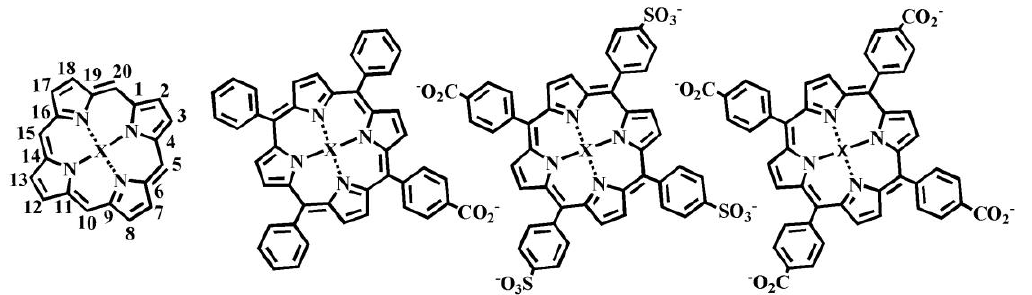
Figure 1. Structures of the porphyrin parent compound and those porphyrins used in the presented studies; from left to right: porphine; 5-mono(4-carboxyphenyl)-10, 15,20-triphenyl porphine (C TPP); meso-tri(4-sulfonatophenyl)mono(4-carboxyphenyl) 1 porphine (C S TPP); and meso-tetra(4-carboxyphenyl) porphine (C 1 3 formation occurs through interaction of the central nitrogen atoms indicated here with an „X‟.